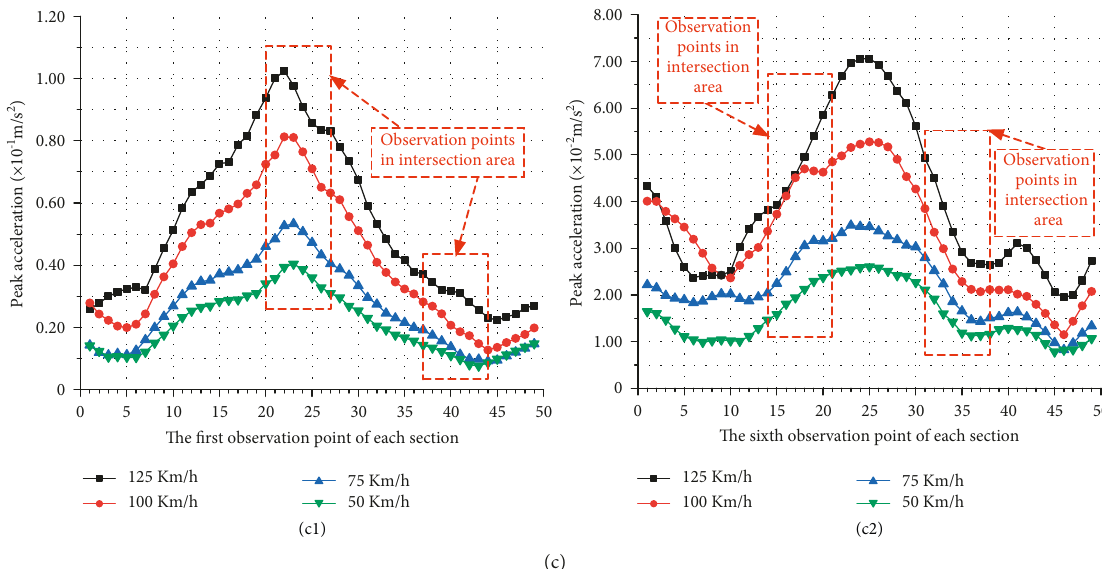
Figure 9: Peak acceleration of observation points on the existing tunnel: (a) shield excavation reaches the 15th ring on the left; (b) shield excavation reaches the 30th ring on the left; and (c) shield excavation reaches the 44th ring on the